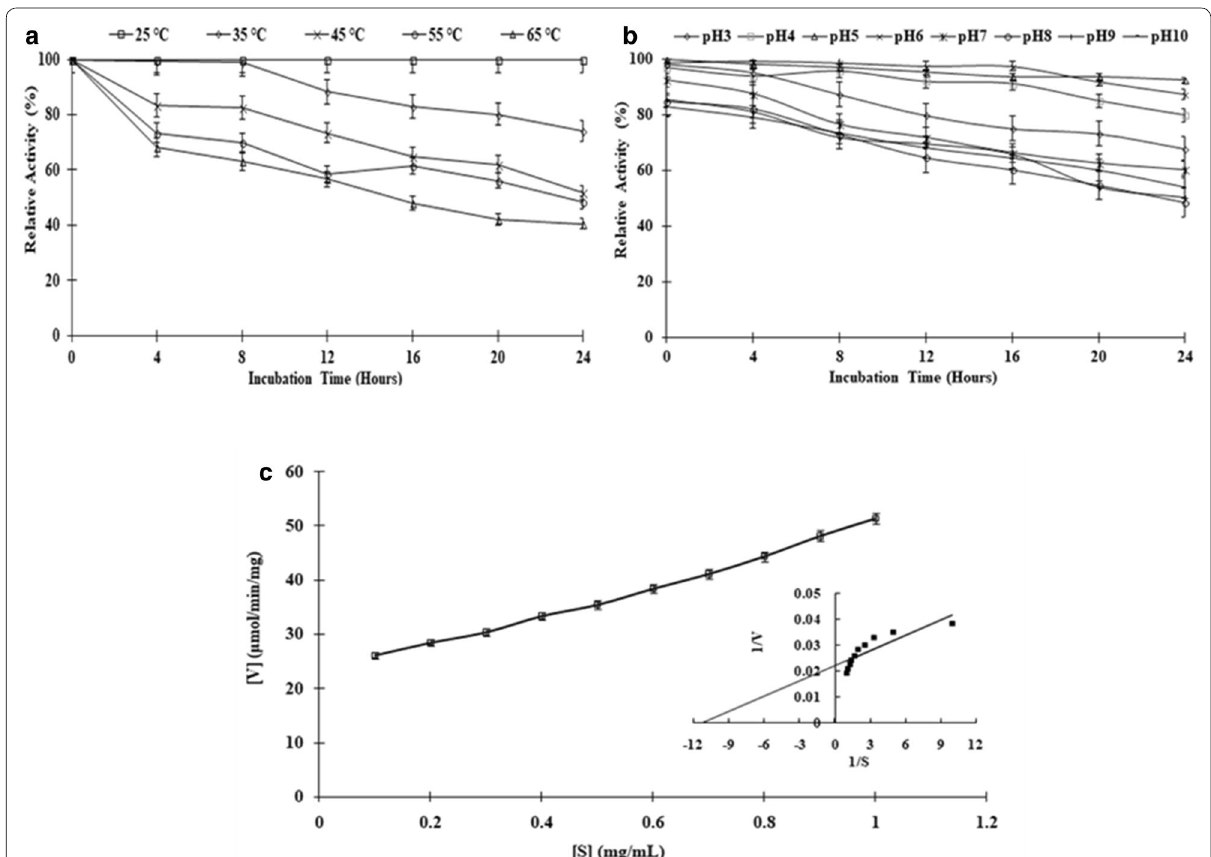
Fig. 4 Stability and kinetic analysis of partially purified Schizophyllum commune NAIMCC-F-03379: a thermal stability of the partially purified cellulase enzyme at different temperature (25–65 °C) for different interval of time. b Stability of the partially purified cellulase enzyme produced at different pH (3–10) for different interval of time. c Kinetics (Michaelis–Menten and Lineweaver–Burk plots) of cellulase enzyme for CMC as